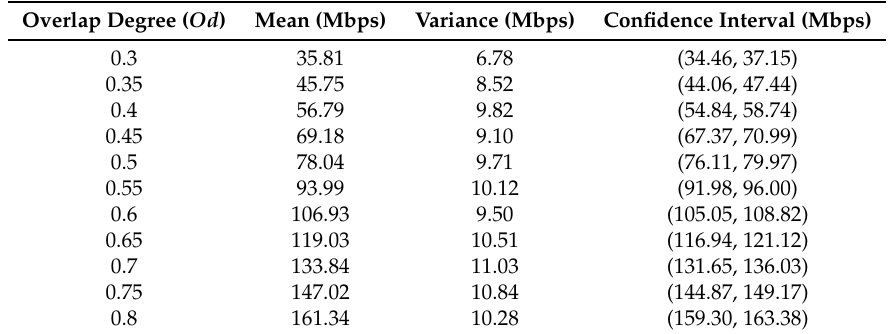
Table 2. Statistical analysis considering overlap degree of data ( N = 20, L = 10, Borderlength = 200 m).